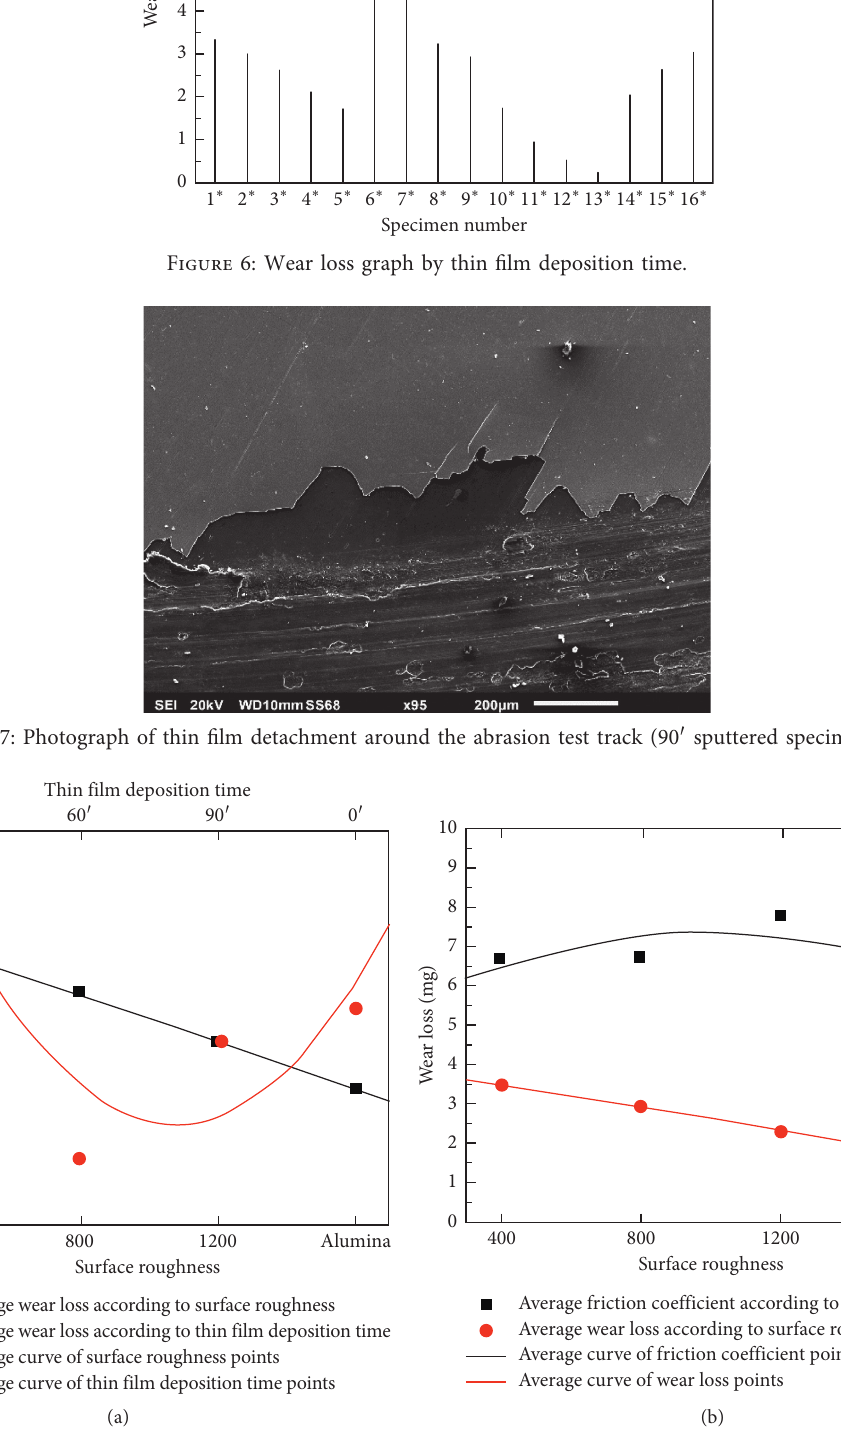
Figure 8: Graph organized according to average of wear loss and average of friction coefficient: (a) average of wear loss according to surface roughness and thin film deposition time; (b) the average of friction coefficient and the average of wear loss according to the surface roughness.